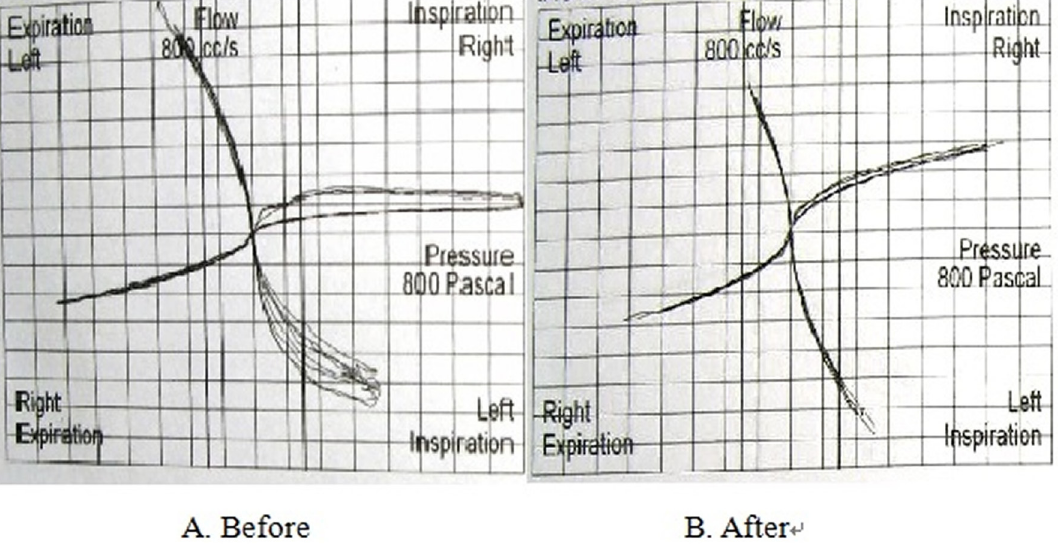
Residual Volume Changes in the Upper Respiratory Tract After wearing the obturator, the RV/TLC significantly decreased by 7.9% (P = 0.004, power = 0.932). Refer to Table 4 for the results.